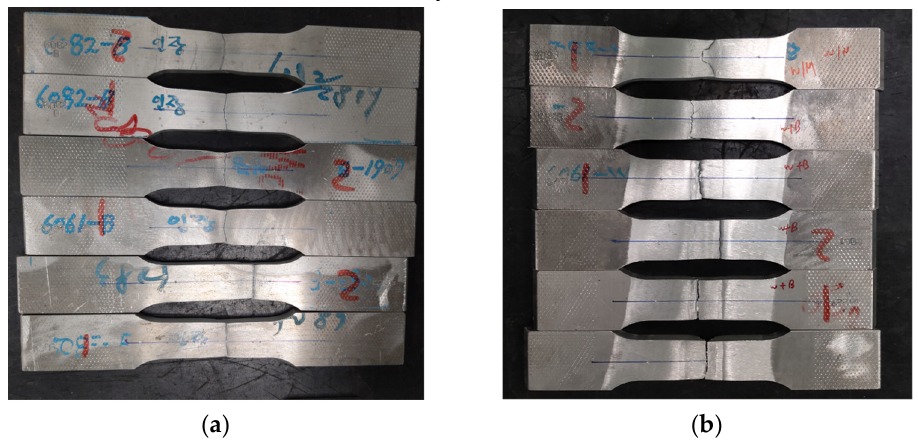
Figure 7. Fracture state of test specimens: ( a ) Base metal; ( b ) Welded metal.